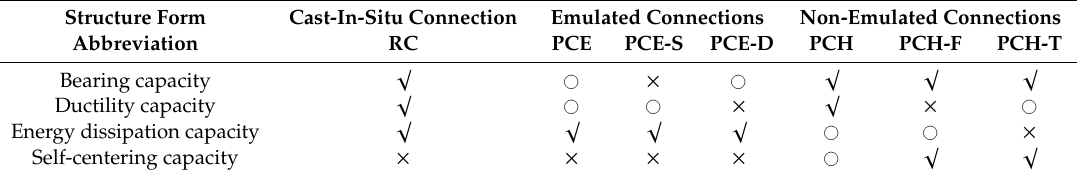
Table 2. The connection forms researched.